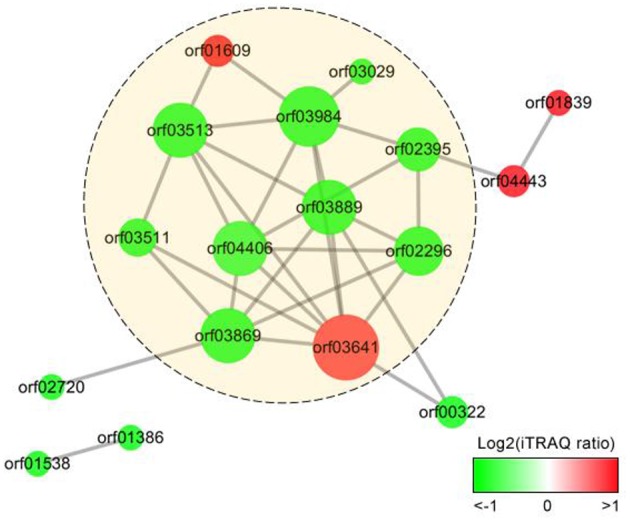
Protein-protein interaction (PPI) networks of the extracellular proteins differentially expressed in A. hydrophila under iron starvation condition. The gradient color indicates iTRAQ protein ratio (on a log2 scale), and size represents protein interaction frequency. Predicted extracellular proteins are displayed in yellow circles.